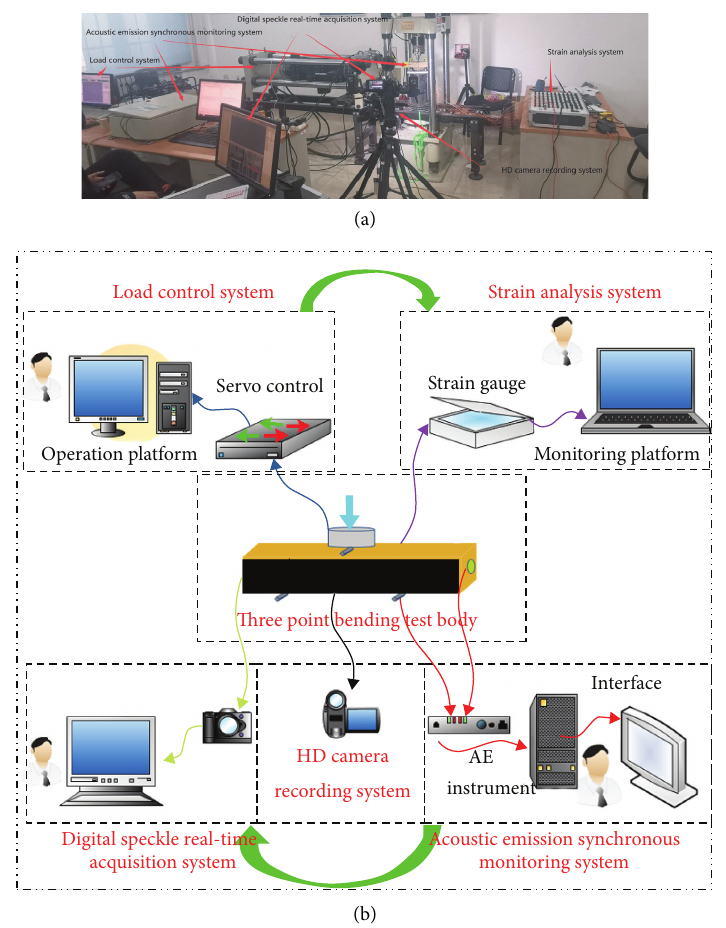
Figure 3: Test system. (a) Physical drawing of the experimental system. (b) Schematic diagram of the experimental